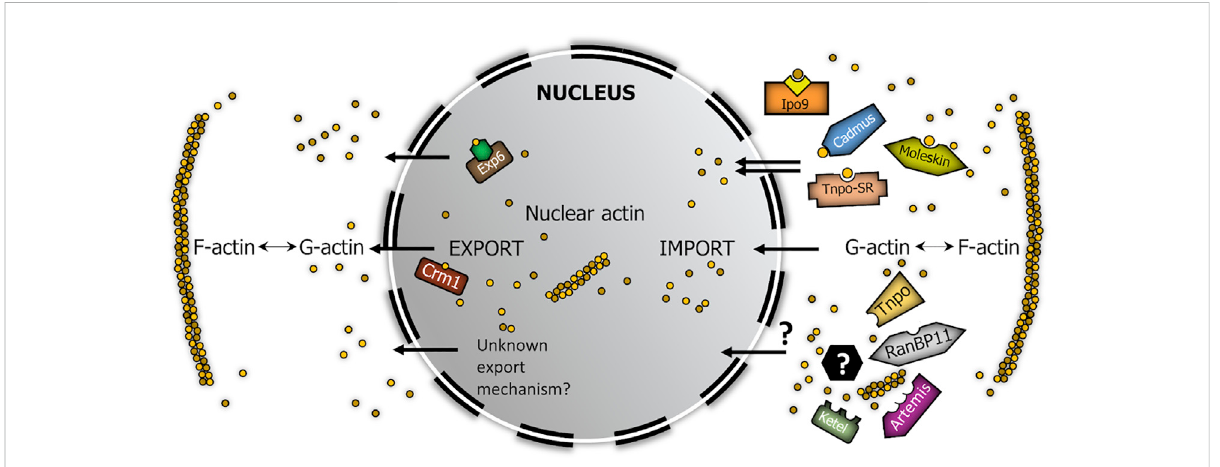
FIGURE 6 Model summarizing therobust nucleo-cytoplasmic transport ofactin in Drosophila . Brown circles represent actin monomers.Yellow square